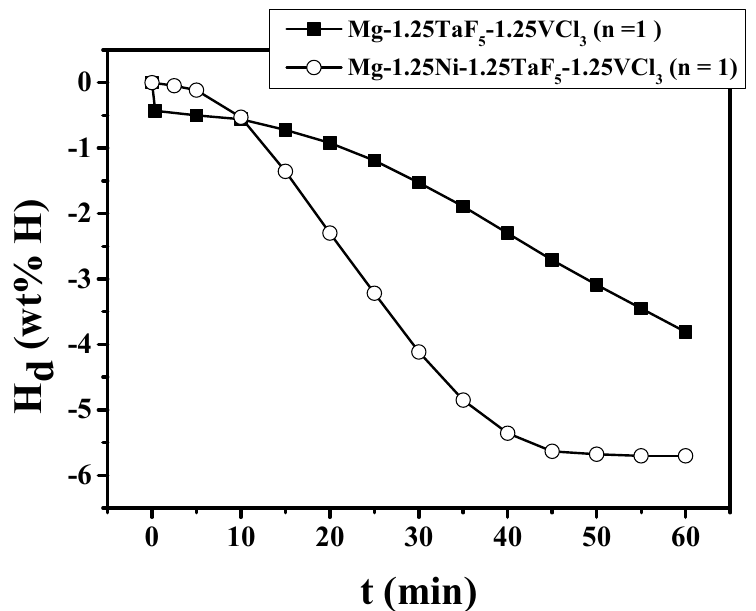
Figure 2. H d vs. t curves at 593 K under 1.0 bar H 2 at n = 1 for Mg-1.25TaF 5 -1.25VCl 3 and Mg-1.25Ni-1.25TaF 5 -1.25VCl 3 .